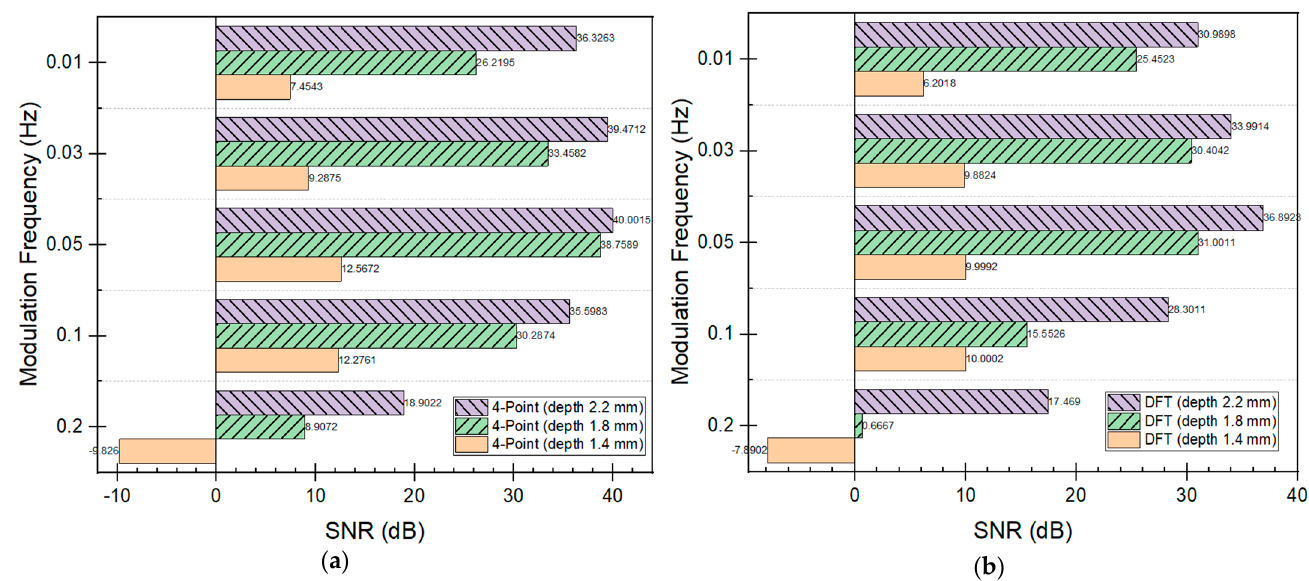
Figure 17. SNR value according to different defect depth in sample group 4: ( a ) HA, ( b ) FFT.